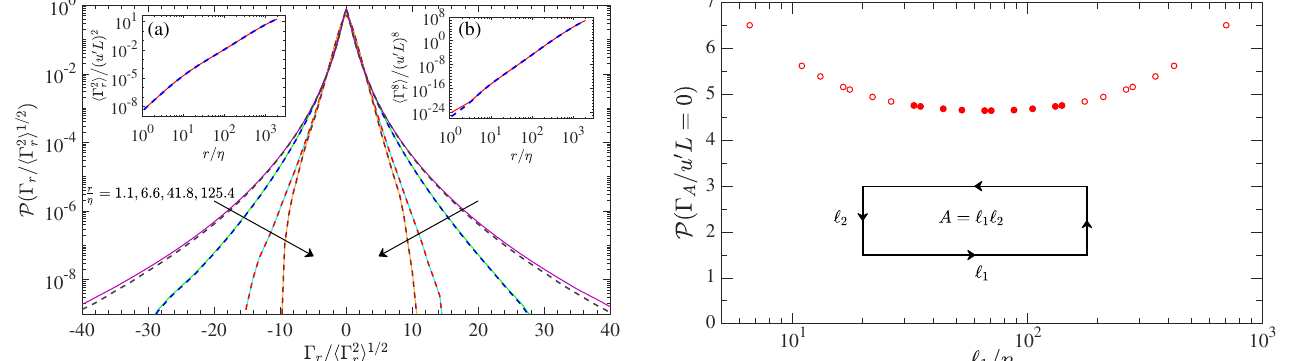
FIG. 15. Peak values of PDF of normalized circulation, =u 0 L , at 4096 3 , R ¼ 650 , around closed rectangular contours Γ A λ with fixed area, but different perimeters, A ¼ l 1 l 2 ¼ 4646 . 4 η 2 , ffiffiffiffi p A as a function of side, l 1 . The plot is symmetric around l 1 ¼ due to statistical isotropy of the underlying velocity field (which holds by construction). Solid symbols correspond to contour dimensions ð l 1 ; l 2 Þ with both legs in IR, while open symbols correspond to contours with at least one leg outside IR. The PDF peaks tend to an approximately constant value for inertial loops.